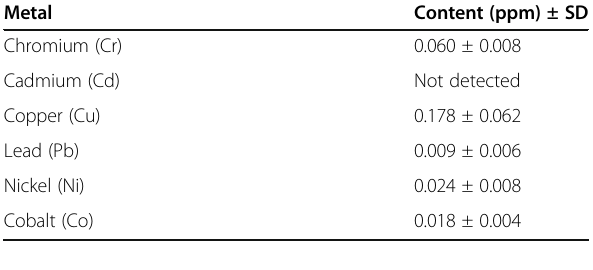
Table 2 Elemental analysis of Khaya senegalensis gum powder